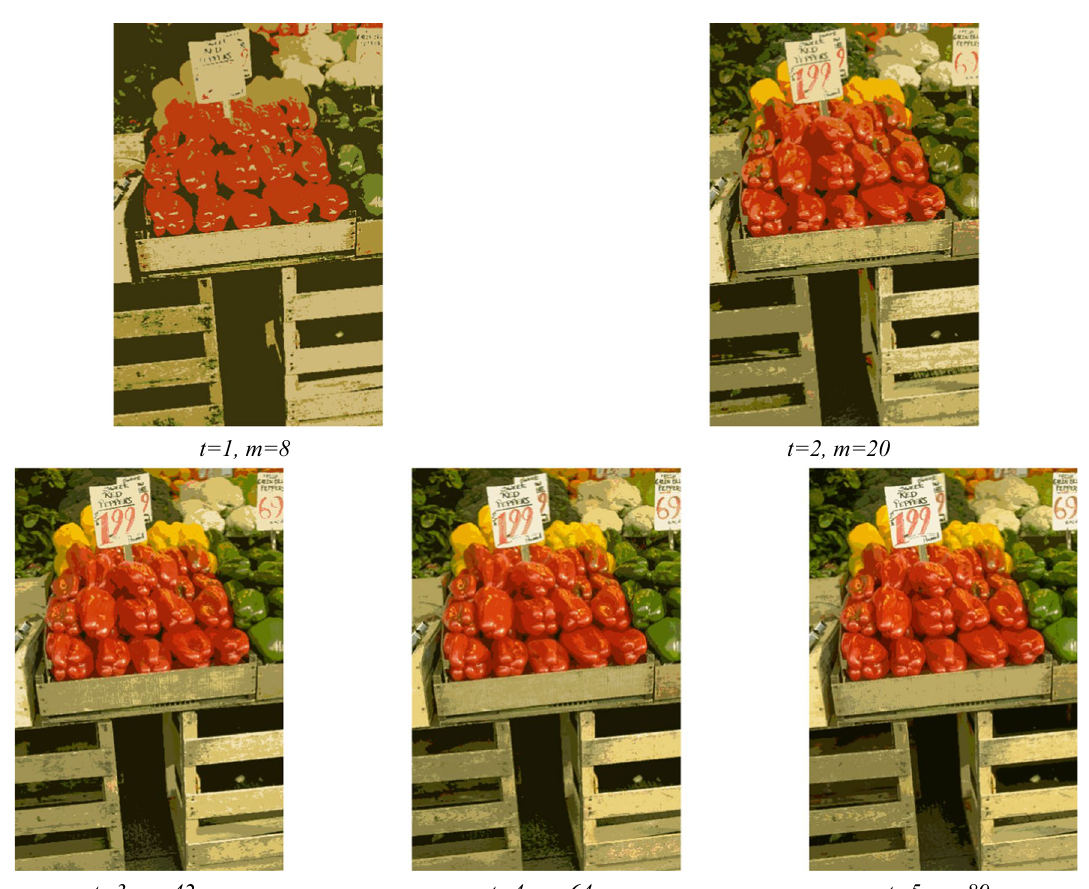
Fig. 17 Quantized 12003 image using